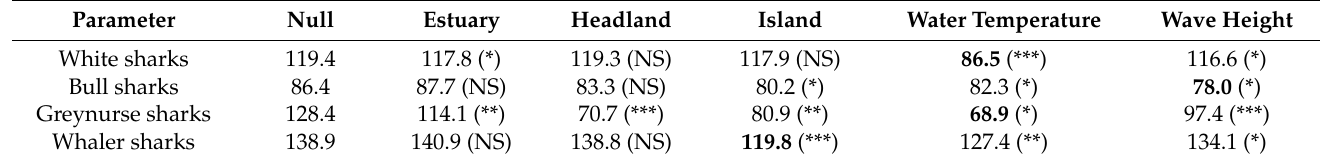
Table 1. Akaike Information Criteria (AIC) for each model of detection probability in response to intercept only (null), distance (m) to the nearest estuary, headland, and island habitats, as well as water temperature ( ◦ C), and wave height (m) for each shark genus. Parentheses enclose significance tests for spline coefficients equal to zero.